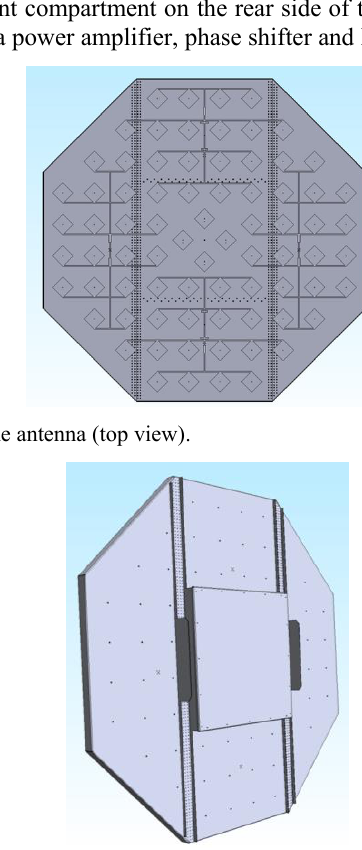
Fig. 9. The appearance of the antenna (bottom